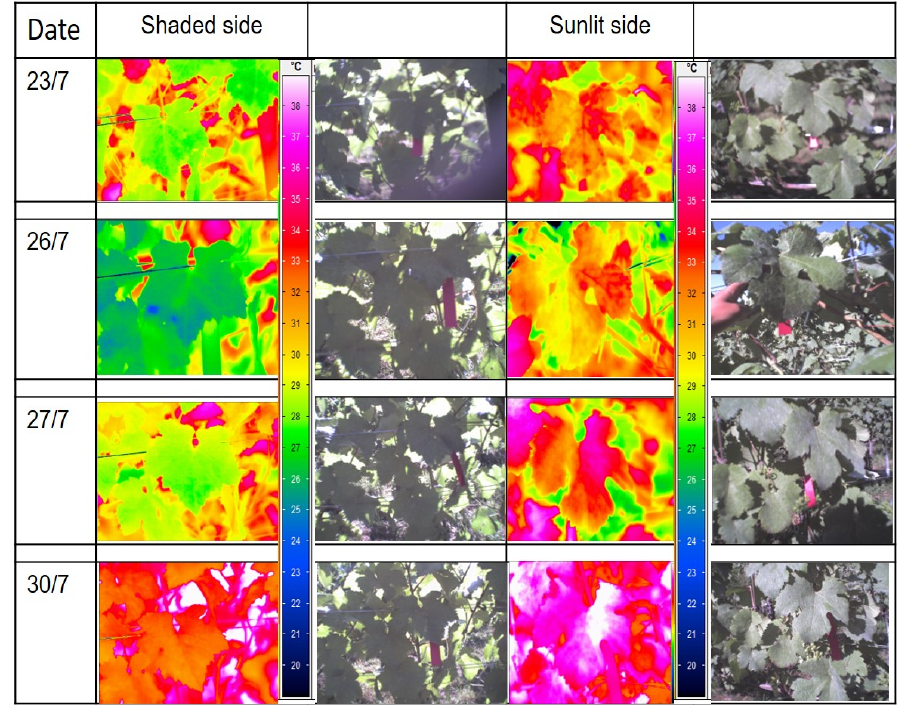
Figure 4. Infrared and RGB images of sunlit and shaded leaves during different dates of experiment; evaluated leaves are marked with red tape.